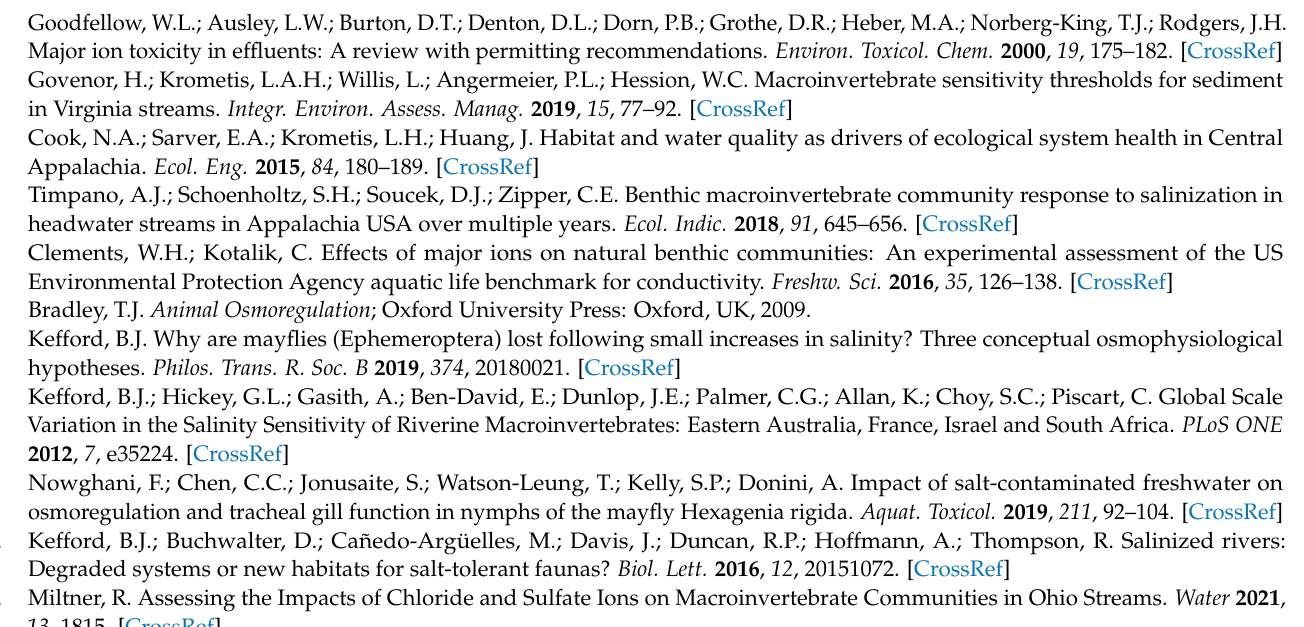
of O&G WWTPs mixing zone analysis; Table S4: Table 1 (cid:48) s constituent concentrations expressed as activity; Table S5: Algae periphyton taxa and DRM/ANOVA results; Table S6: Taxa identified and enumerated in gravel and drift samples; Table S7: Rank ordering of EC50 invertebrate taxa-level responses comprising the SpCond RSDs; Table S8: Community and system level measures modeled; Table S9: Rank ordering of community-level responses comprising the SpCond RSDs; Table S10: Rank ordering of system-level responses comprising the SpCond RSDs; Table S11: HCs estimated at the 5th, 10th, and 20th percentiles of respective RSDs with 95% confidence intervals by recipe and level of ecological organization; Table S12: Taxa loading lists for PRC analyses. Table S13: HCx equivalences estimated based on the observed ionic composition of each of the dosed recipes; Figure S1: Single-species ex situ tests additional results; Figure S2: PRC and taxa relative abundance bar graphs for community-level measures of periphytic algae and gravel invertebrates. Figure S3: PRC and taxa relative abundance bar graphs for community-level measures on drift and emergence; Figure S4: Drifting invertebrate total counts collected at different time points; Figure S5: Total emergence captured at different time